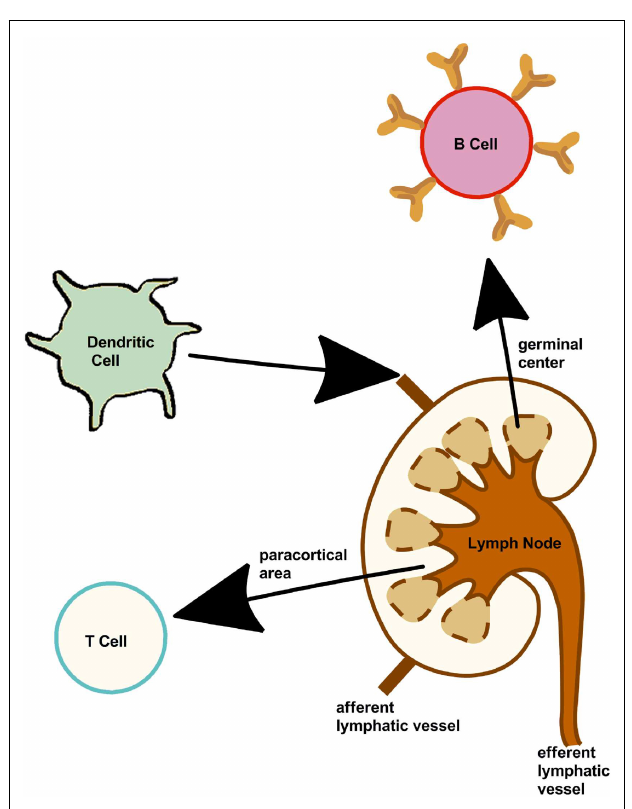
FIGURE 2 | Cells of the immune system . Lymph nodes present along the lymphatic vessels contain specialized compartments where immune cells collect and encounter antigens. B,T, dendritic cells, and other immune cells are present, thus can mount an effective and appropriate immune response.